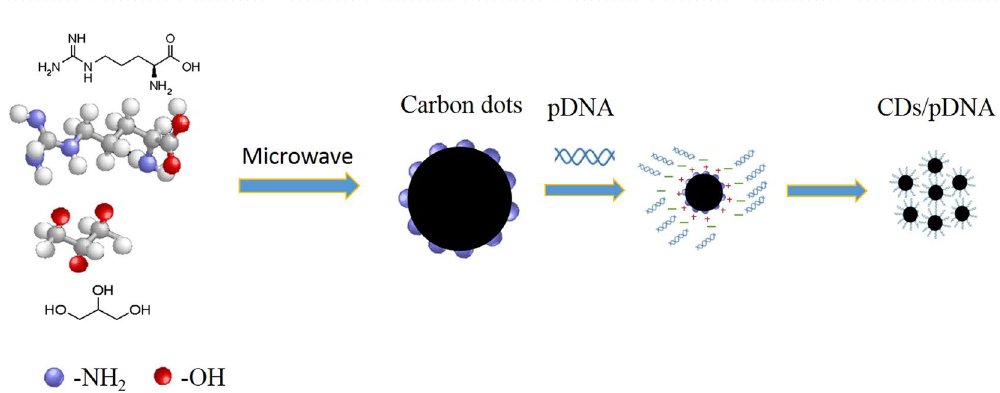
Figure 5. Identification of MEF differentiation into chondrocytes. ( a ) Immunohistochemical staining for collagen II using DAB. Blank: MEFs, 3days-14days; MEFs transfected with CDs/pDNA complexes for 3, 7 or14 days; scare bars = 50 μ m. ( b ) Toluidine blue staining. Blank: MEFs, 3 days-14days; MEFs transfected with CDs/ pDNA complexes for 3, 7 or14 days; ( c ) Western bolt results of collagen II and GAG, and β -actin was used as control. scare bars = 50 μ m.